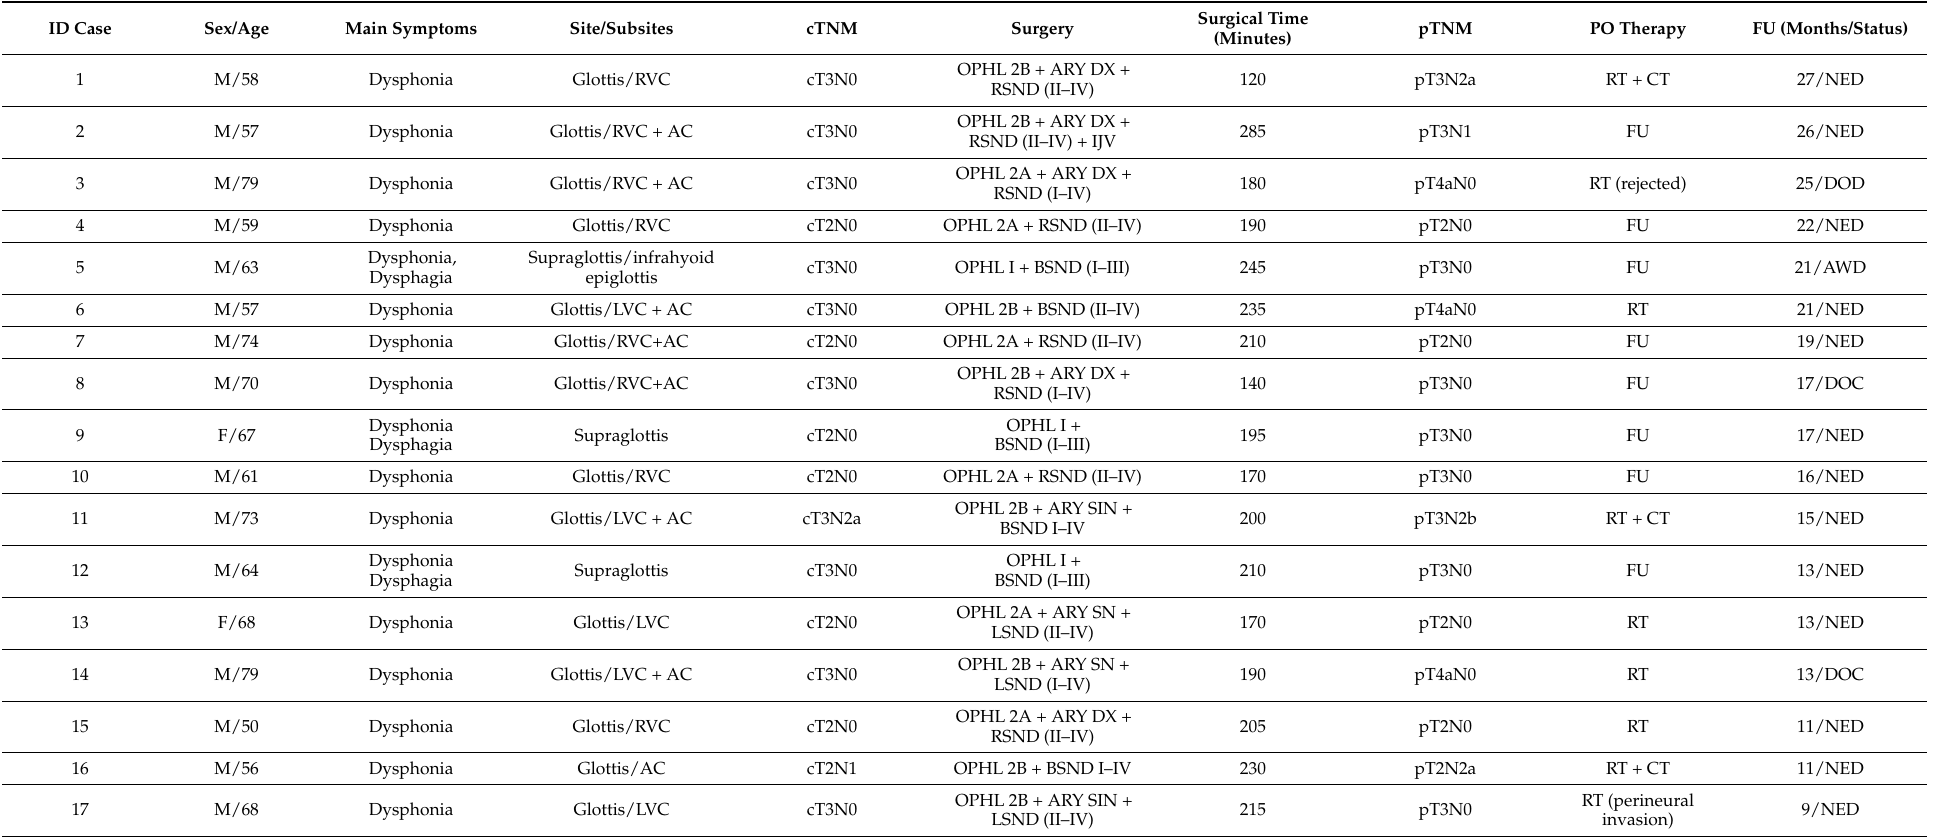
Table 1. Demographics, surgical and oncological features of patients